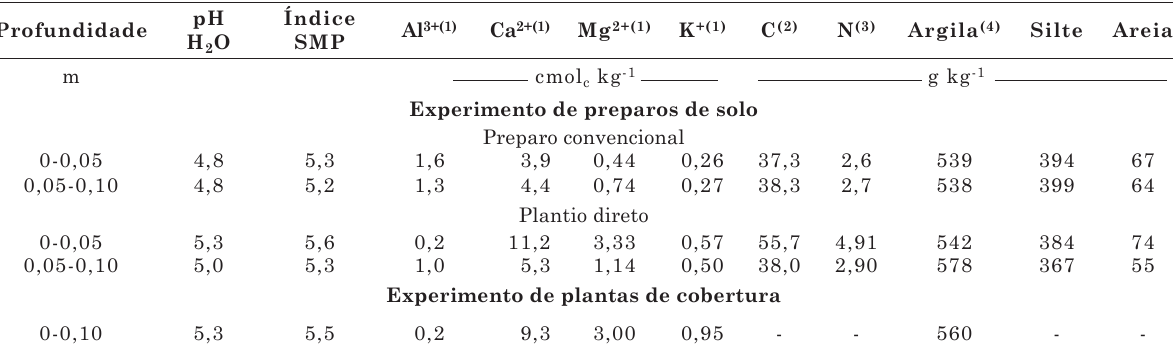
(1) teores trocáveis (tedesco et al., 1995). (2) Carbono orgânico total determinado por combustão seca em equipamento SHimadzU toC-V CSH. (3) nitrogênio total determinado por digestão sulfúrica e destilação (tedesco et al., 1995). (4) Granulometria segundo Costa